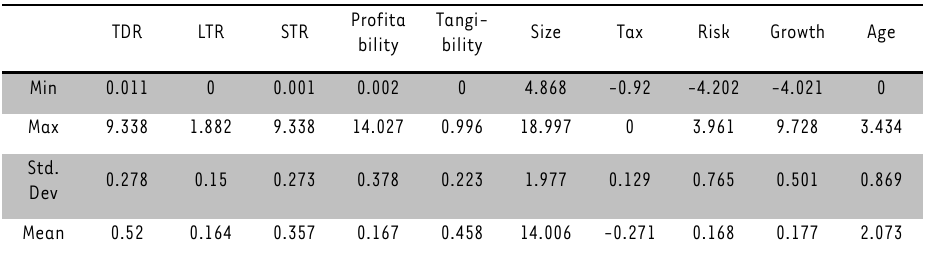
TABLE A2: Descriptive